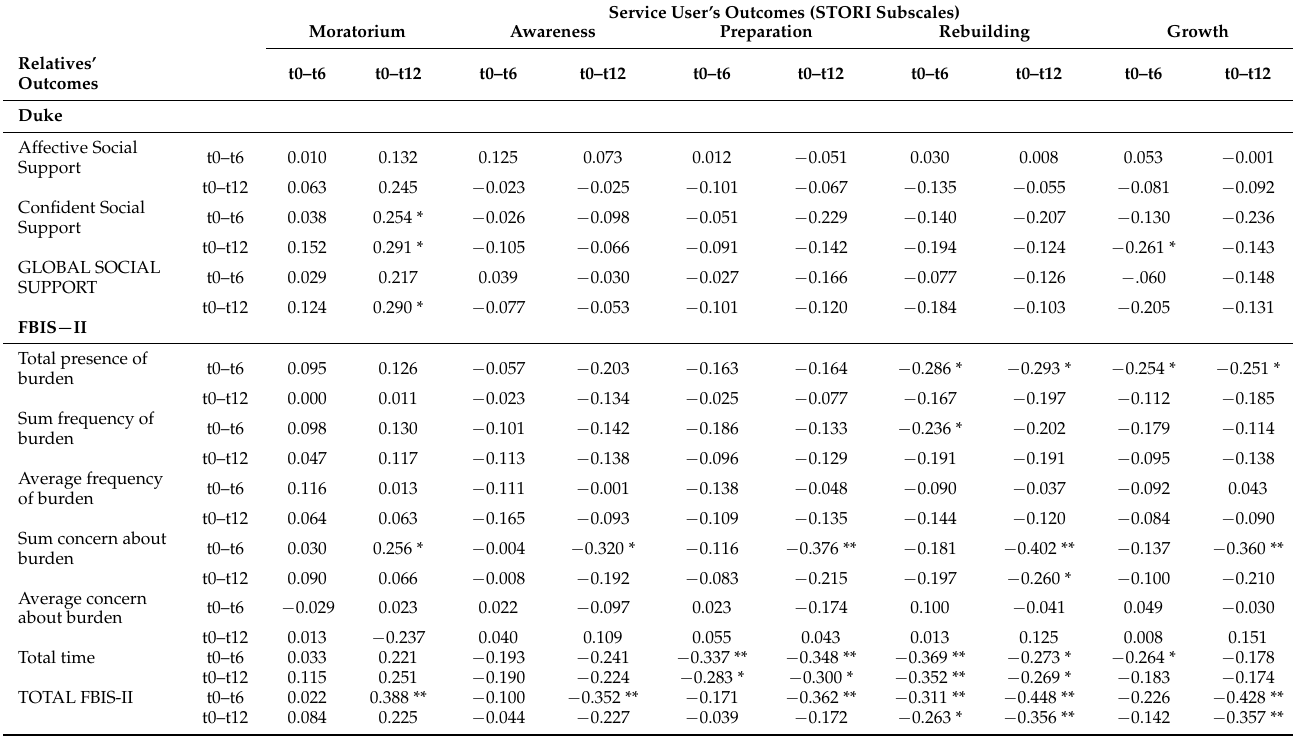
Table 3. Pearson correlations between service users’ and relatives’ differential scores.